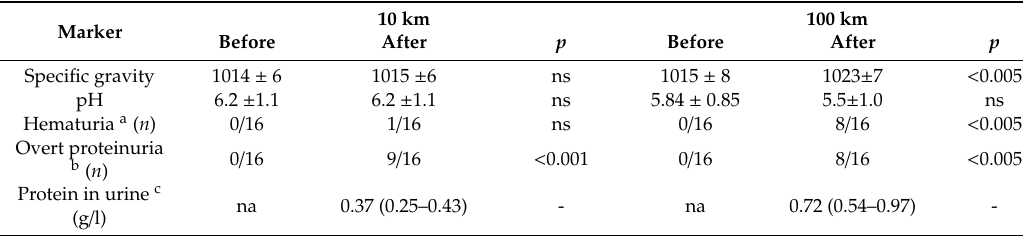
Table 3. Changes in urinalysis after both